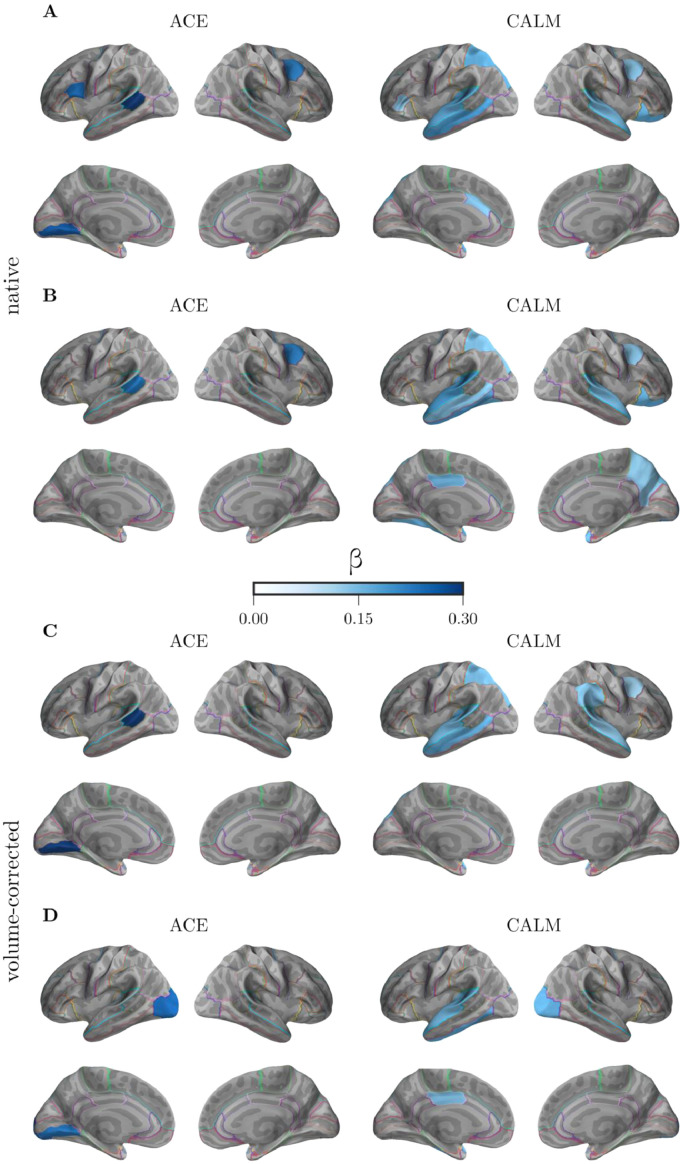
Regression coefficients for the regional associations between local efficiency (Ej) and the cognitive factor scores (A, C) and the learning factor scores (B, D) in the ACE and CALM sample. The top panel shows native associations and the bottom panel shows associations corrected for the grey matter volume of each region.